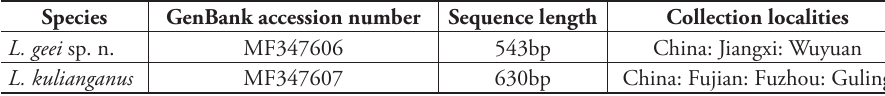
Table 1. Voucher specimen